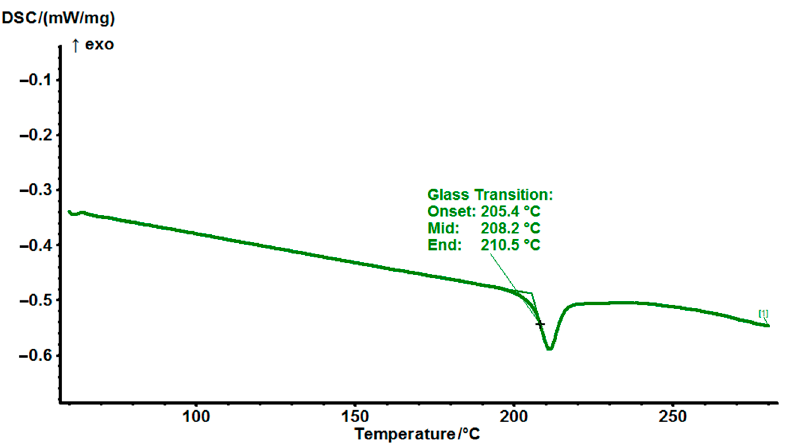
Figure 8. DSC thermograms cured EG514 at a heating rate of 10 ◦ C/min. Regarding the DSC thermogram of non-cured EG531 the first peak at 67 ◦ C corre- sponds to solid SER epoxy resin melting, after that the reaction occurs at 194 ◦ C (Figure 9).